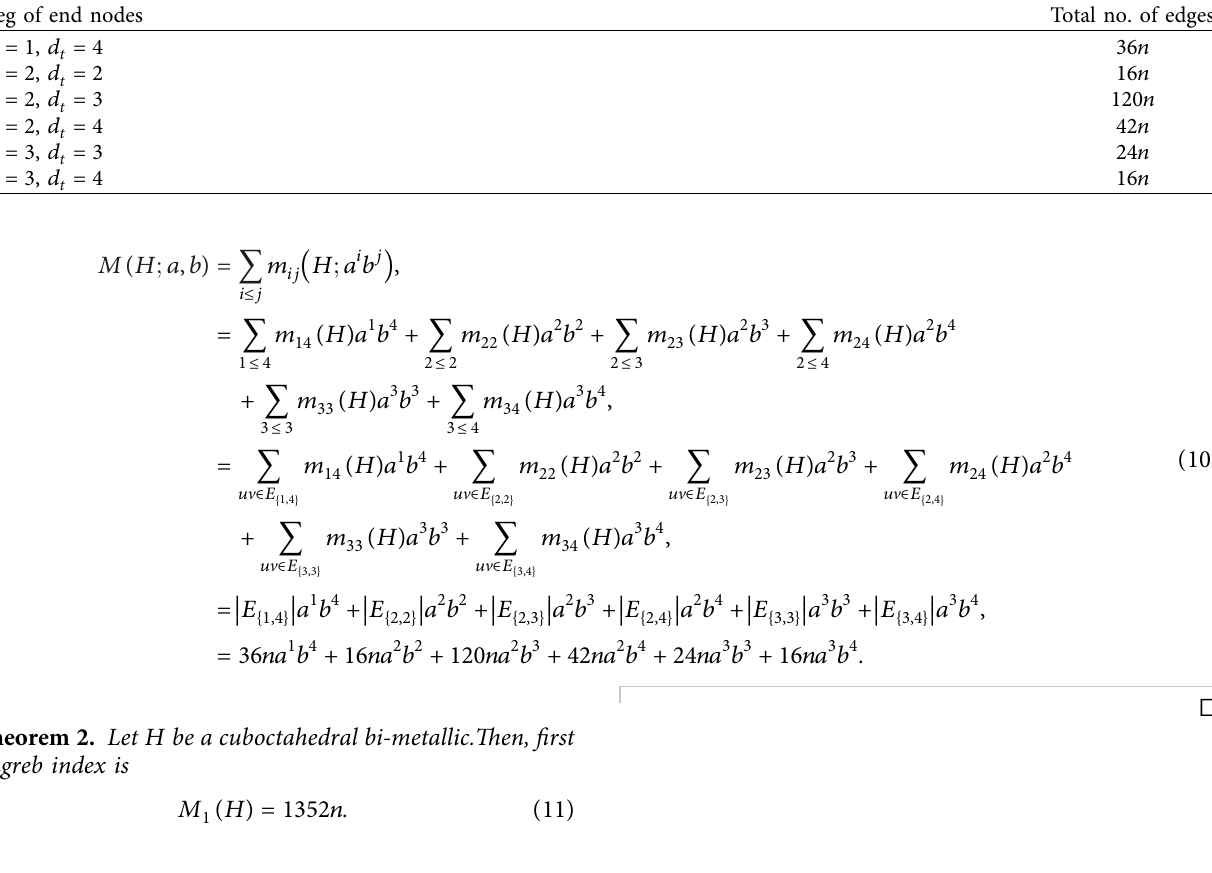
Table 2: Edge partition of cuboctahedral bi-metallic